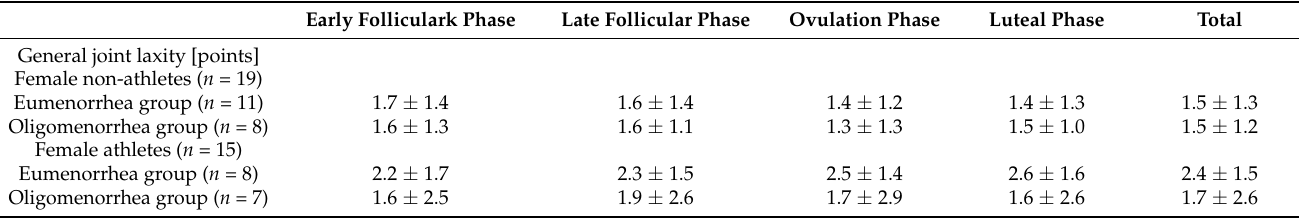
Table 4. Changes in general joint laxity during the menstrual cycle.